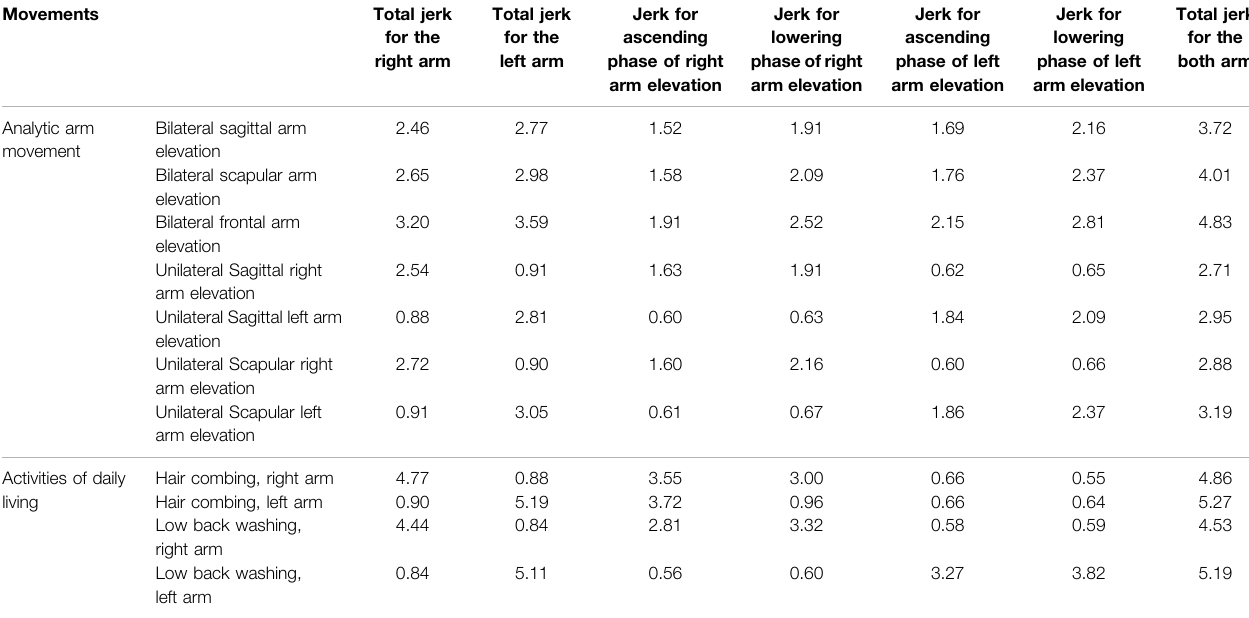
(cid:129) The ascending jerk against the lowering jerk for bilateral and unilateral arm elevations, with r (Ascending)/(Lowering) . (cid:129) The jerk of arm elevations in the three different planes (Frontal, Sagittal, and Scapular). The comparisons involved the pairwise jerk ratio [ r (Front)/(Sag) , r (Front)/(Scap) and r (Sag)/(Scap) ].